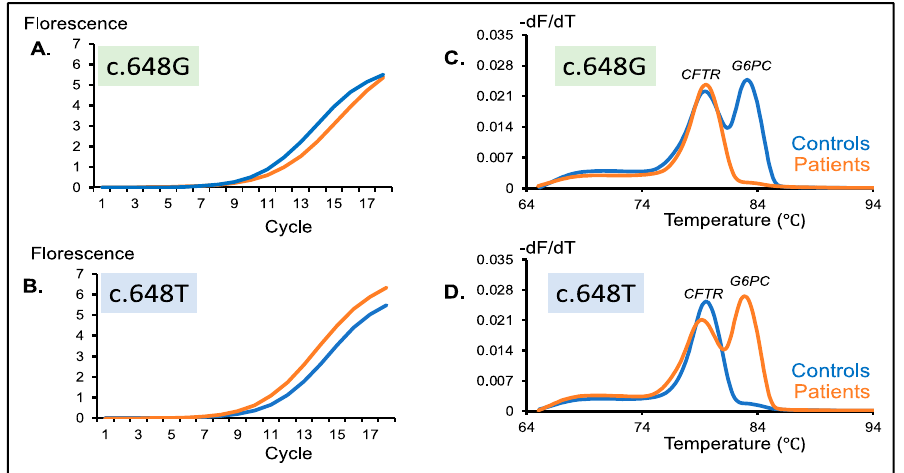
Figure 2. Detection of wild-type and mutant G6PC peaks in healthy controls (c.648G) and patients (c.648T). Amplification curve of a healthy control and a patient generated from multiplex PCR of CFTR and ( A ) a wild-type G6PC c.648G-specific primer or ( B ) a mutant G6PC c.648T-specific primer. Similar amplification efficiency was observed in both situations. Melting peaks of a healthy control and patient generated from multiplex PCR of CFTR and ( C ) a wild-type G6PC c.648G-specific primer or ( D ) a mutant G6PC c.648T-specific primer. Healthy controls show two distinct peaks with the c.648G-specific primer and a single peak with the c.648T-specific primer. Meanwhile, patients disclosed a single peak with the c.648G-specific primer and two distinct peaks with the c.648T-specific primer. Blue and orange lines indicate healthy controls and patients,